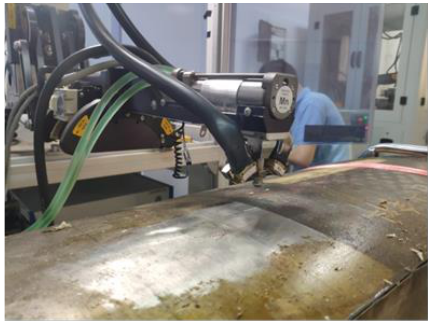
Figure 6. The residual stress test site.